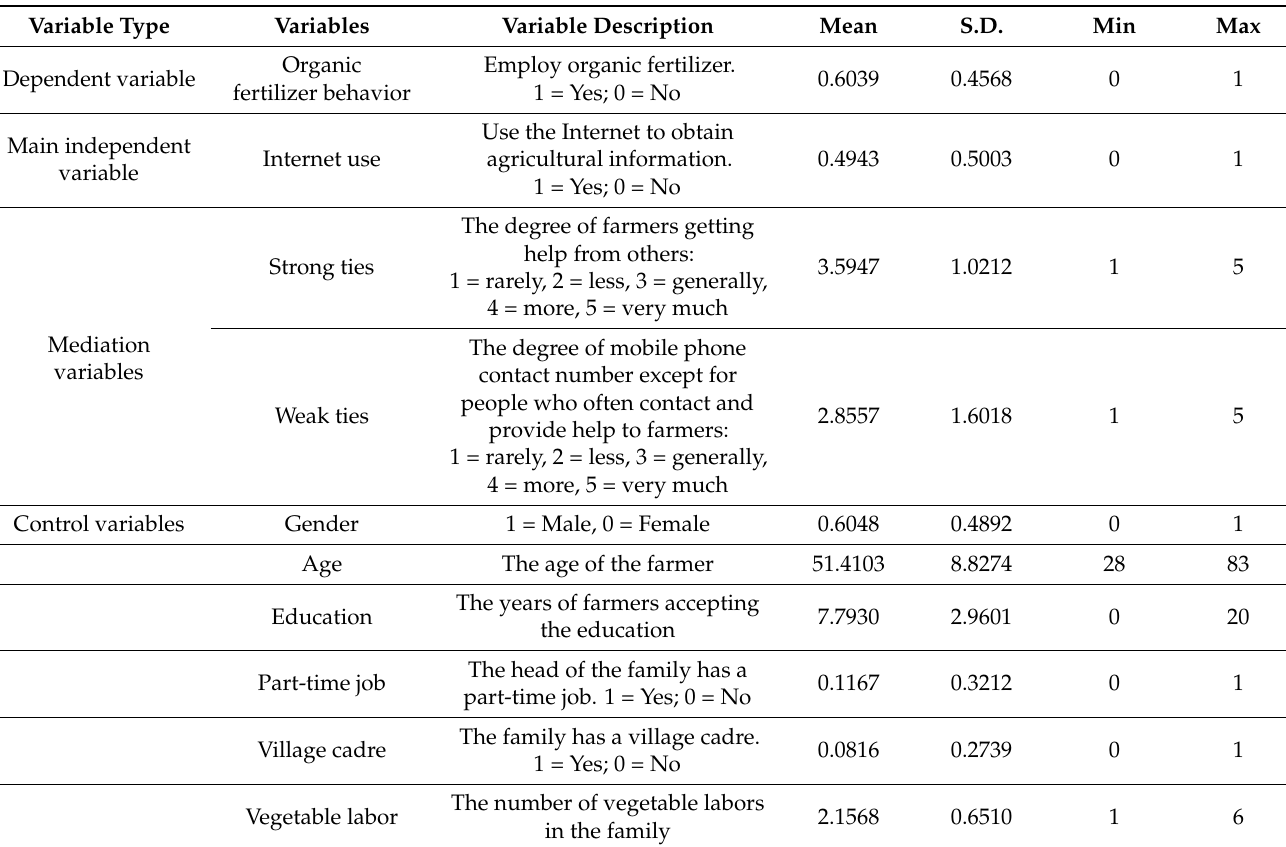
Table 1. Variable definition and statistical